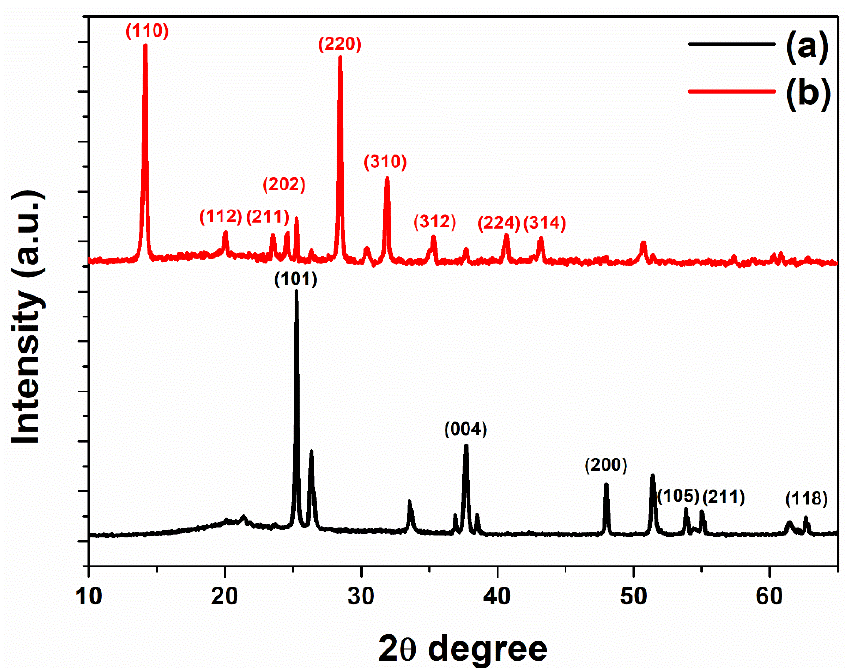
Figure 6. XRD images of ( a ) nanopatterned mp-TiO 2 thin-film layer, and ( b ) perovskite on nanopat- terned mp-TiO 2 thin-film layer.